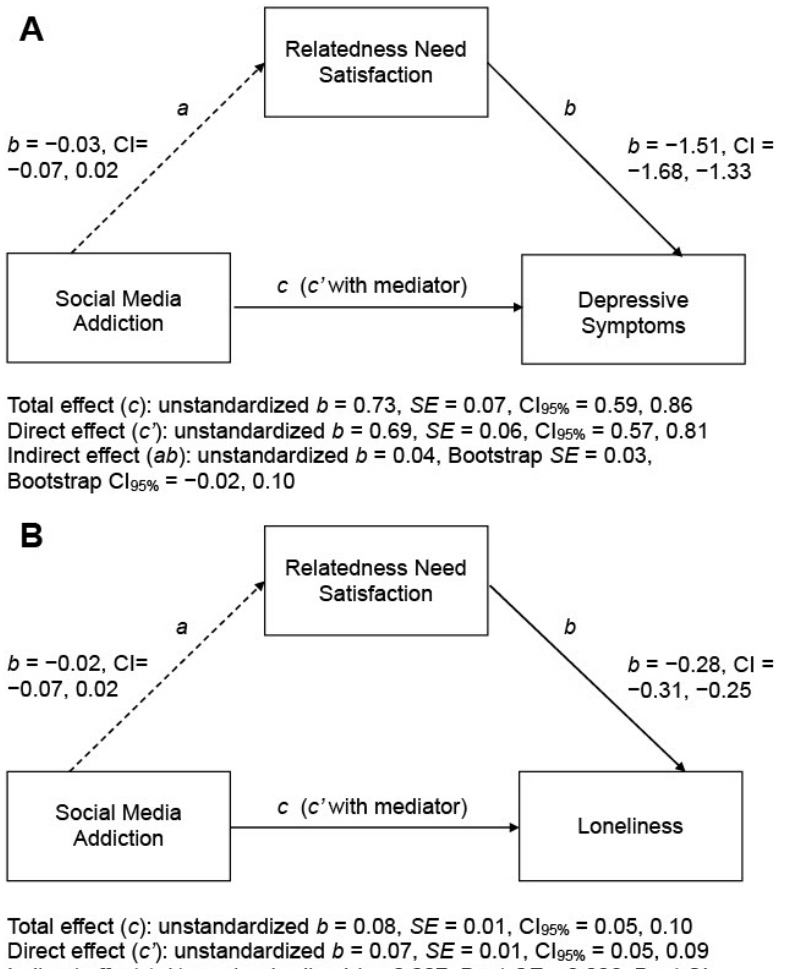
Figure 3. Summary of mediation analyses for testing the relatedness needs-as-requirements model with depressive symptoms ( A ) or loneliness ( B ) as the criterion variable ( n = 1045). Bootstrap analysis of 5000 samples. Sex and age were entered as covariates. All displayed values are unstandardized path coefficients. Non-significant paths are represented by dashed arrows. Boot = bootstrap; SE = standard error; CI = confidence interval.